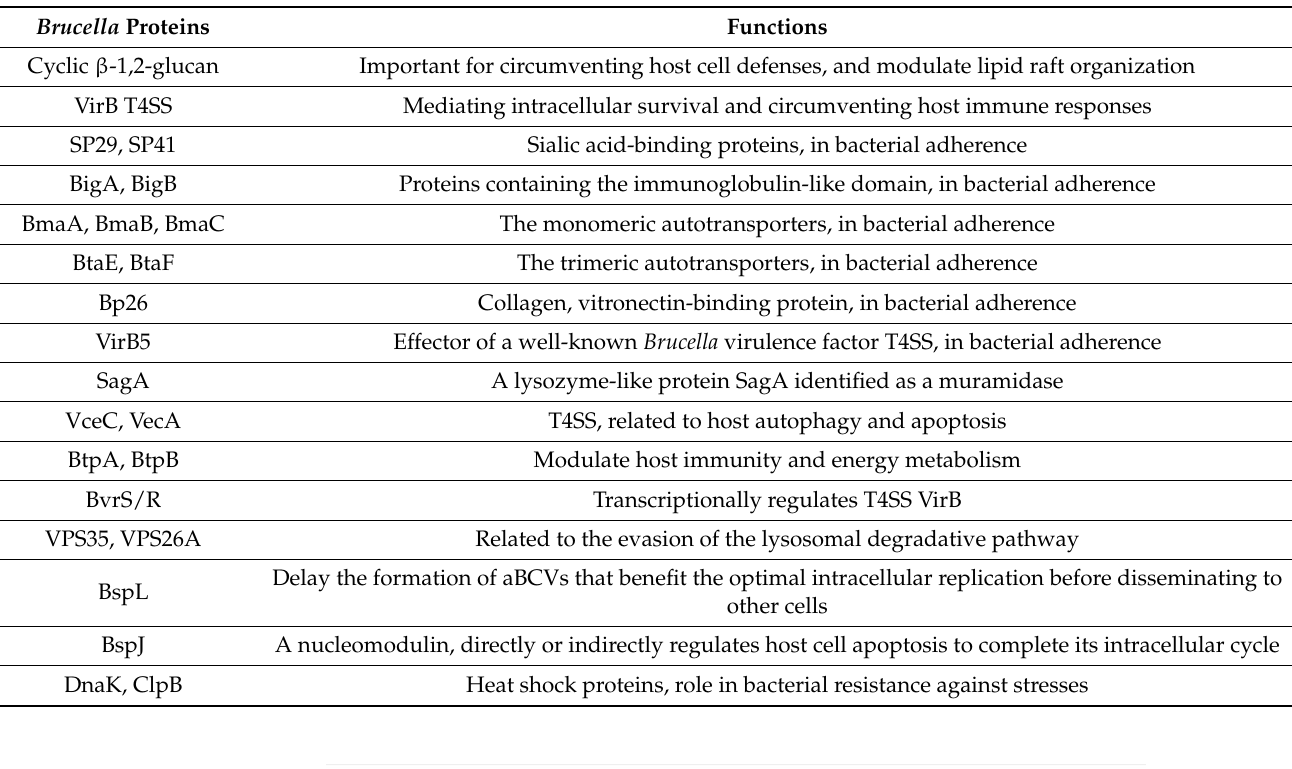
Table 1. Brucella functional proteins in interaction with host cells.